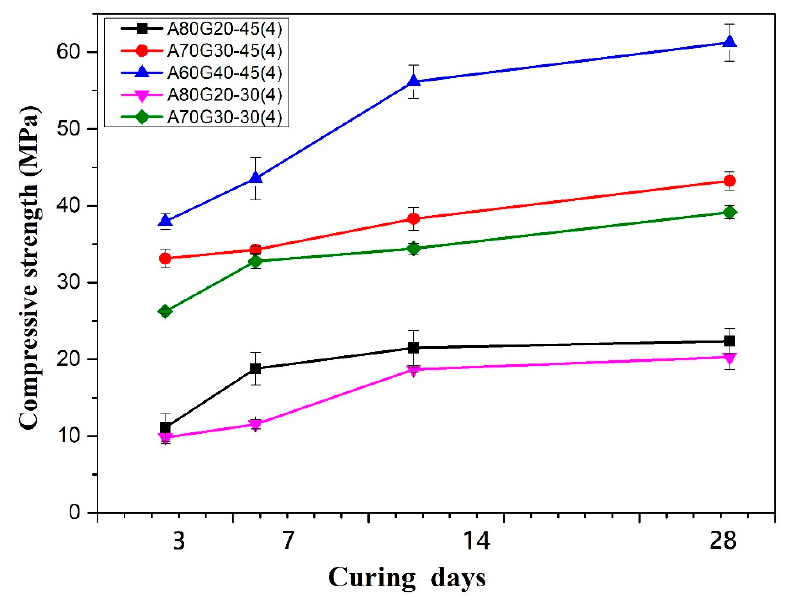
Figure 7. Influence of AS/GGBFS ratio on the compressive strength of AG geopolymer mortar.